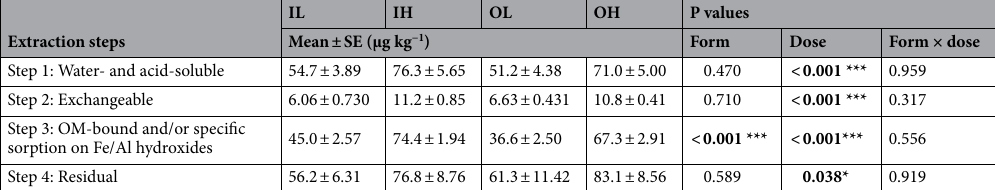
Table 5. Sequential extraction of Se from faecal samples collected on day 14. Significant values are in bold. OH organic minerals offered at higher doses, OL organic minerals offered at lower doses, IH inorganic minerals offered at higher doses, IL inorganic minerals offered at lower doses. The symbol ‘*’ and ‘***’ indicate statistical significances of ANOVA test at p-value < 0.05 and < 0.001,